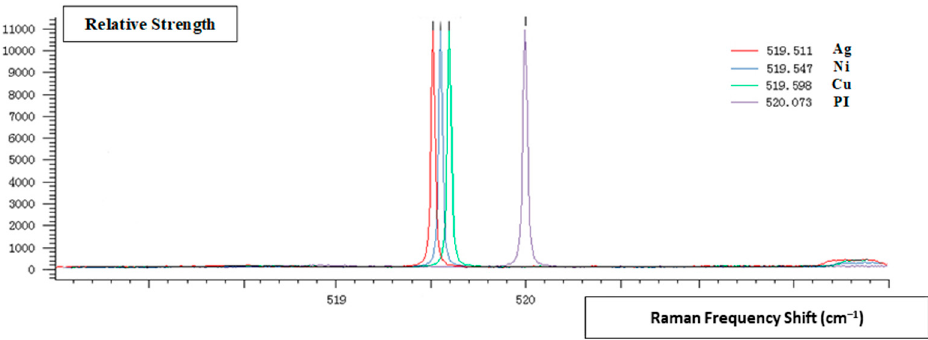
Figure 1 5. Raman Spectroscopy Residual Stress. Figure 15. Raman Spectroscopy Residual Stress.